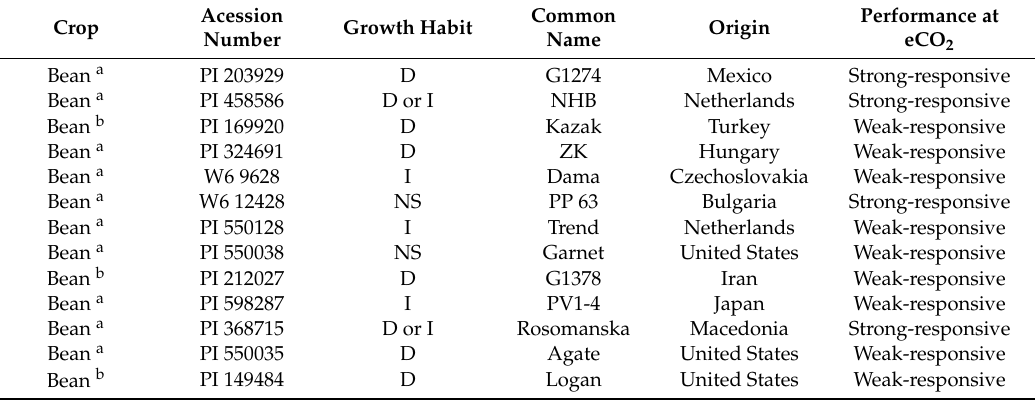
Table 5. List of bean ( n = 18) and soybean ( n = 17) varieties grown at aCO 2 (400 ppm) and eCO 2 (800 ppm). Performance at eCO 2 was obtained from a preliminary FACE experiment to find out the strong-responsive ( > 25% yield increase) and weak-responsive ( < 25% yield increase) varieties against eCO 2